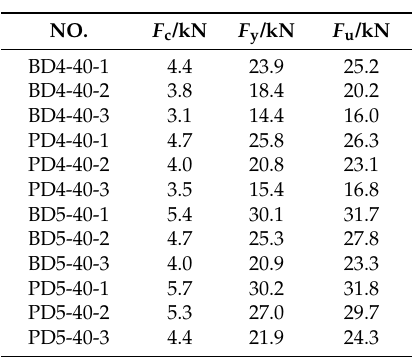
Table 5. Test results of